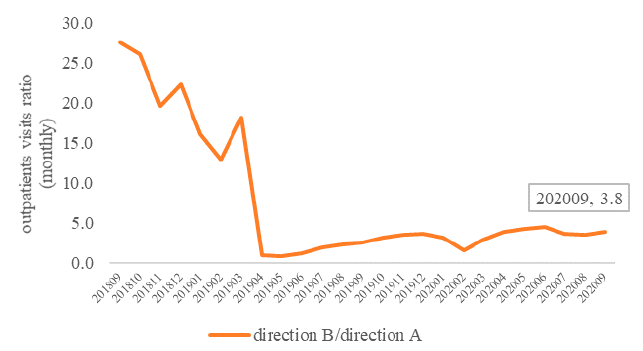
Figure 3. Outpatient visit ratio in both directions (direction B/direction A).